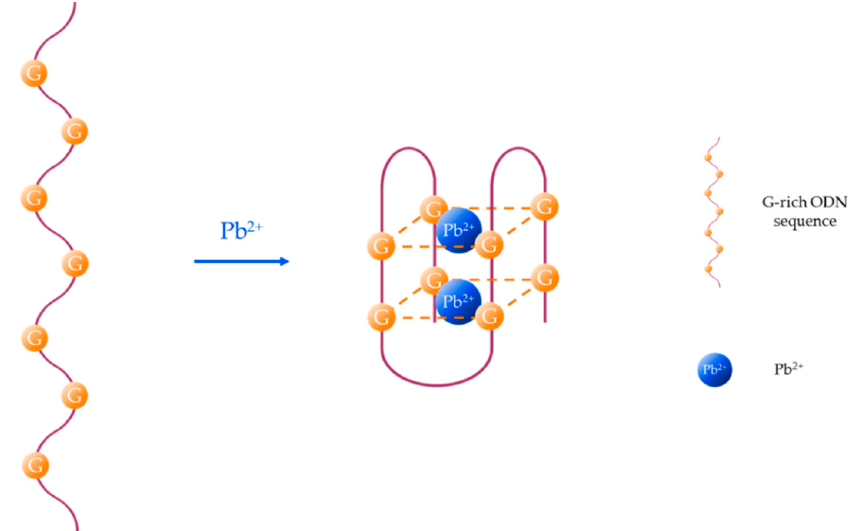
Figure 2. Pb 2+ -induced formation of G-quadruplex structures.